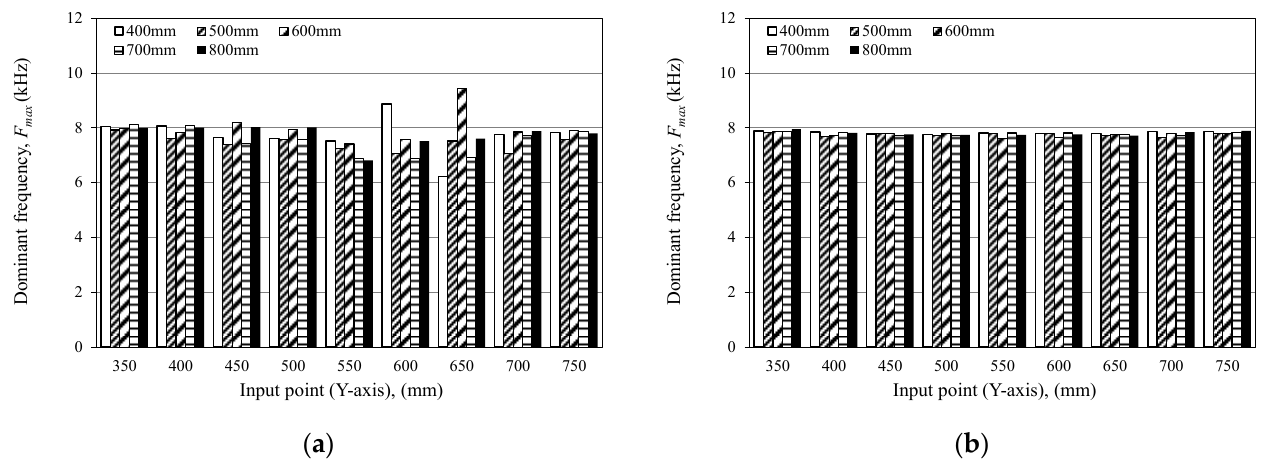
Figure 20. Dominant frequencies: ( a ) Case_1: φ S = 63 mm, Depth =5 0 mm; ( b ) Case_3: φ S = 33 mm, depth = 50 mm.